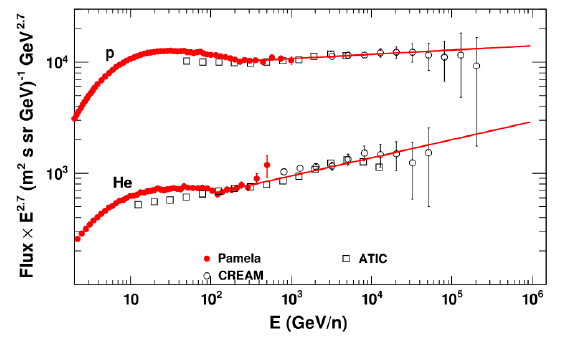
Figure 3. Proton and Helium spectra measured by PAMELA, CREAM and ATIC [10]. The hardening of the spectra at about 200 GeV total energy is clearly